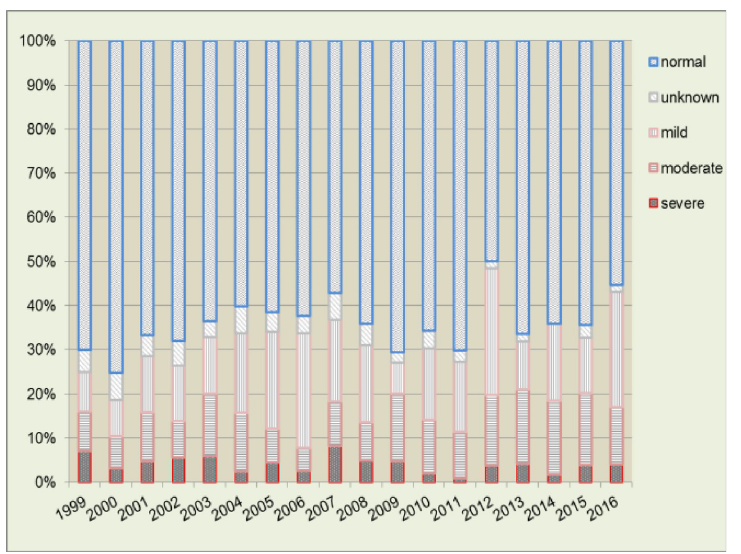
Fig 1. Diabetic ketoacidosis 1999–2016 [according to